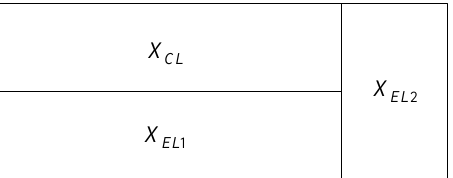
Figure 4. The representation of core layer ( CL ), enhanced layer 1 ( EL 1), EL 2 in the multiplexer (Mux) output.